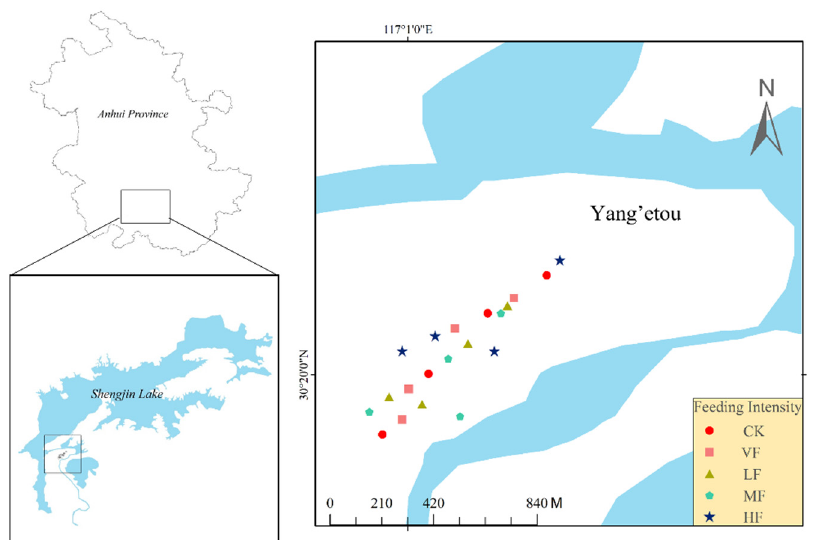
Figure 1. The location of the study area. Different colors represent different foraging intensity (CK, no foraging; VF, very little foraging; LF, light foraging; MF, moderate foraging; HF, heavy foraging).